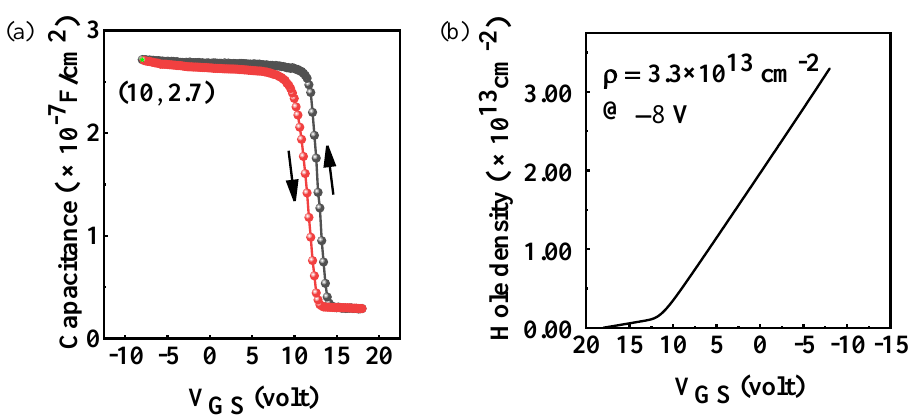
Figure 4. ( a ) C-V curve of Al 2 O 3 /H-terminated MOSFET; ( b ) hole density ρ - V GS